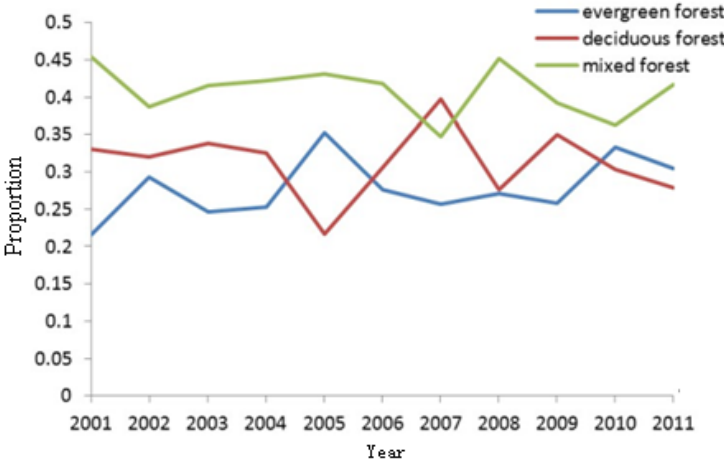
Figure 6. Proportion changes of three categories of forestland over the past 11 years.